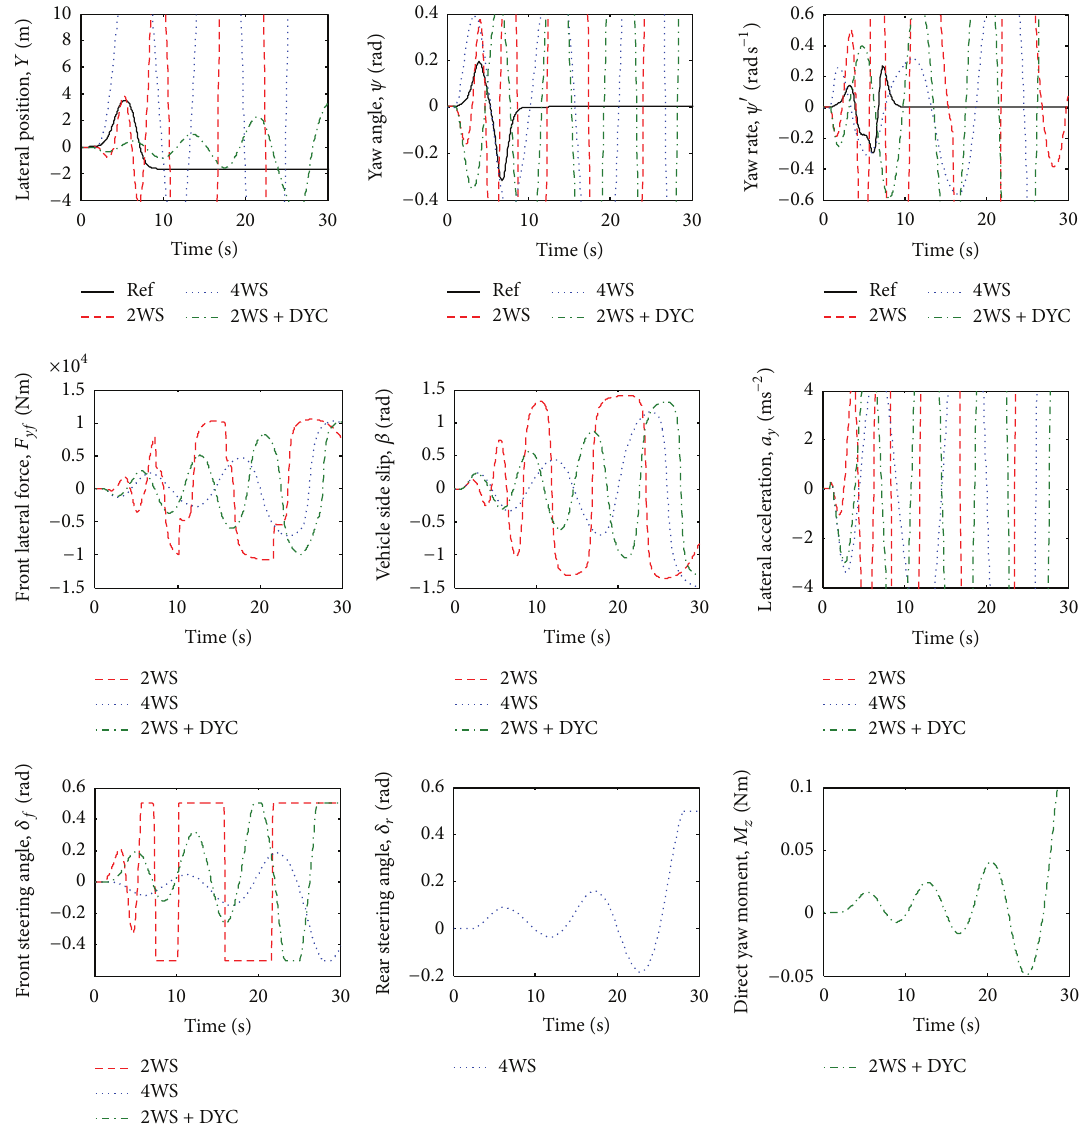
Figure 14: 2DoF controller at 30 ms −1 and 𝜇 = 0.1 by 2WS, 4WS, and 2WS +